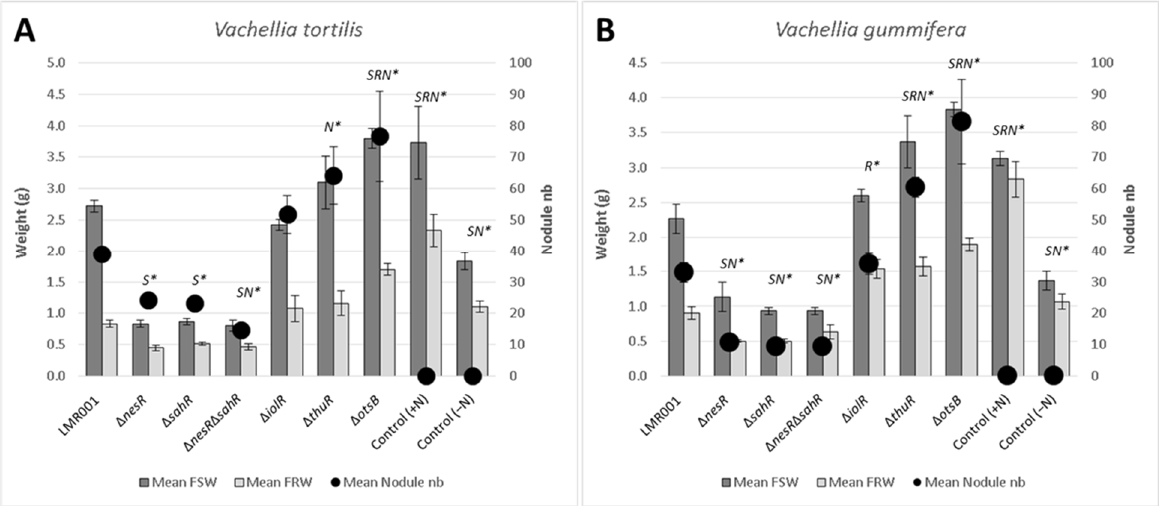
Figure 1. Effects of the mutations on symbiosis development with Vachellia . The mean fresh shoot and root weights (shown, respectively, as FSW, dark grey and FRW, light grey; left axis) and nodule numbers (filled black circles; right axis) in V. tortilis ( A ) and V. gummifera ( B ) are shown for the mutants and non-inoculated control plants either watered using nitrogen complemented nutrient solution (+N) or without nitrogen ( − N), as indicated at the bottom of the bar graphs. Error bars corresponding to standard deviations and significant differences with LMR001 data ( p -value < 0.05, Tukey’s Test) are indicated by “*” preceded by the letter “S”, “R”, and/or “N” for mean shoot, root weights, and nodule numbers, respectively.